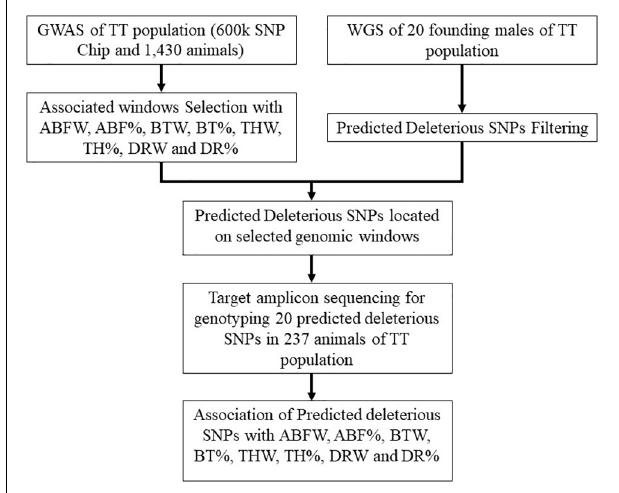
FIGURE 1 | Workflow of genomic analysis